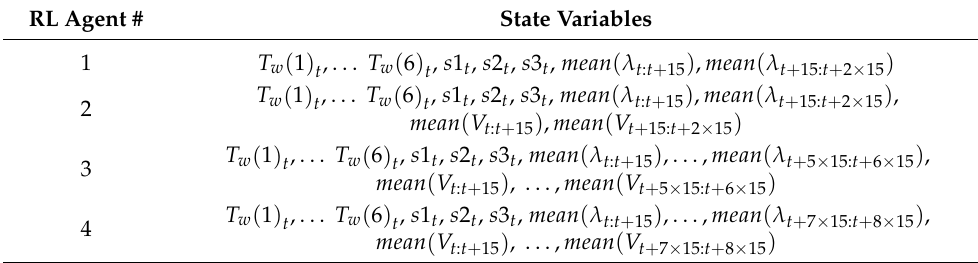
Table 1. State variables of the RL